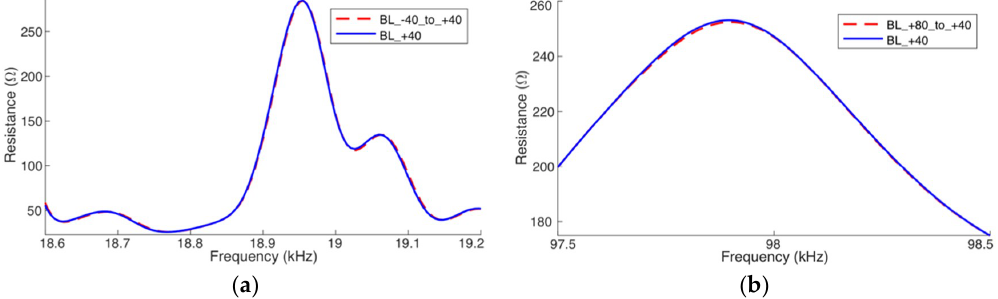
Figure 13. Horizontal compensation—Case 1 (Simulation) pipe-1/PZT-1: ( a ) at low frequency and ( b ) at high frequency.